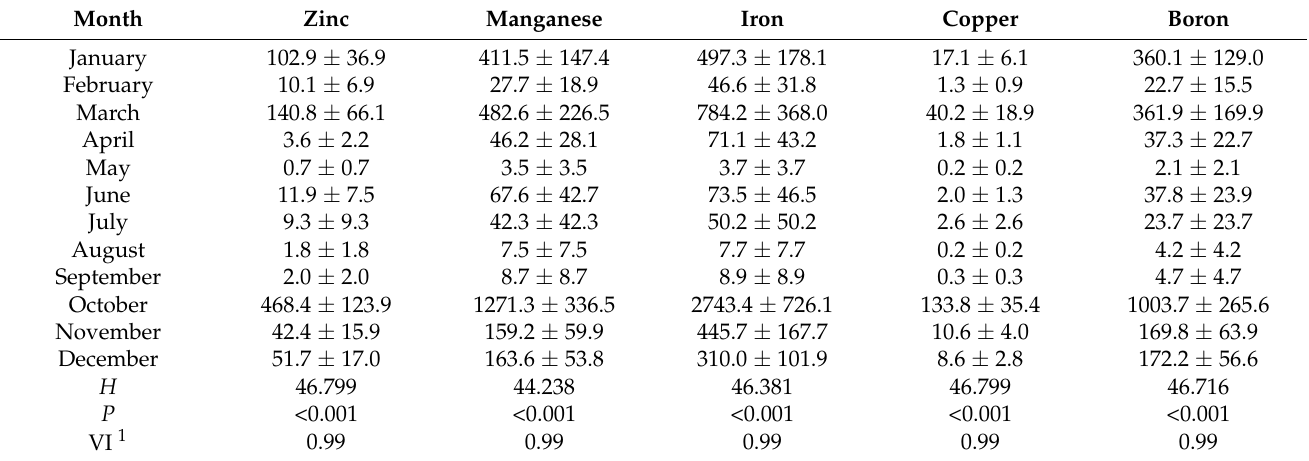
Table 6. The influence of month of year on micronutrient return ( µ g · m − 2 ) in Serianthes nelsonii stem